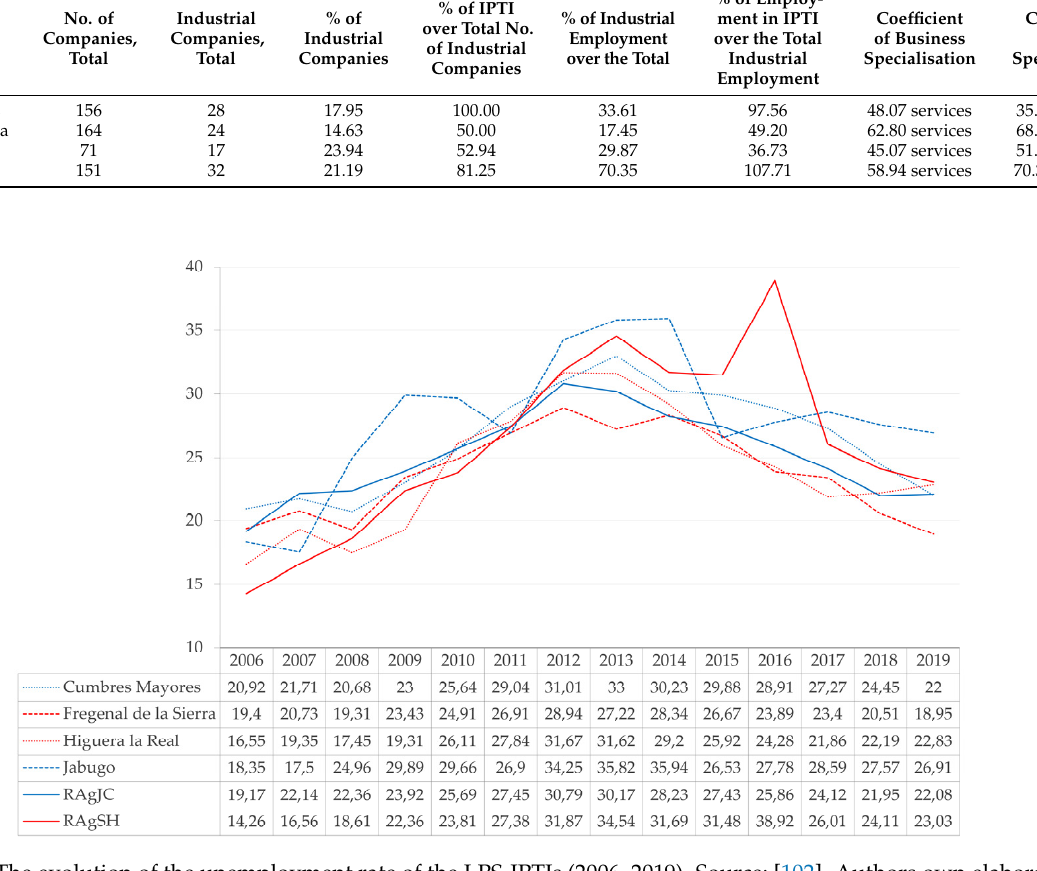
Figure 11. The evolution of the unemployment rate of the LPS-IPTIs (2006–2019). Source: [102]. Authors own elaboration.